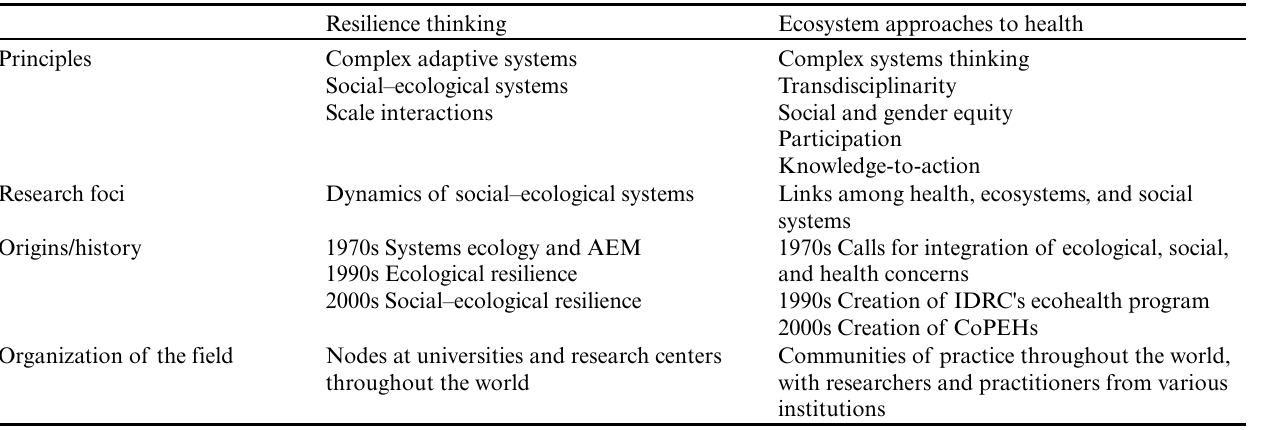
Table 1. Overview of resilience thinking and ecosystem approaches to